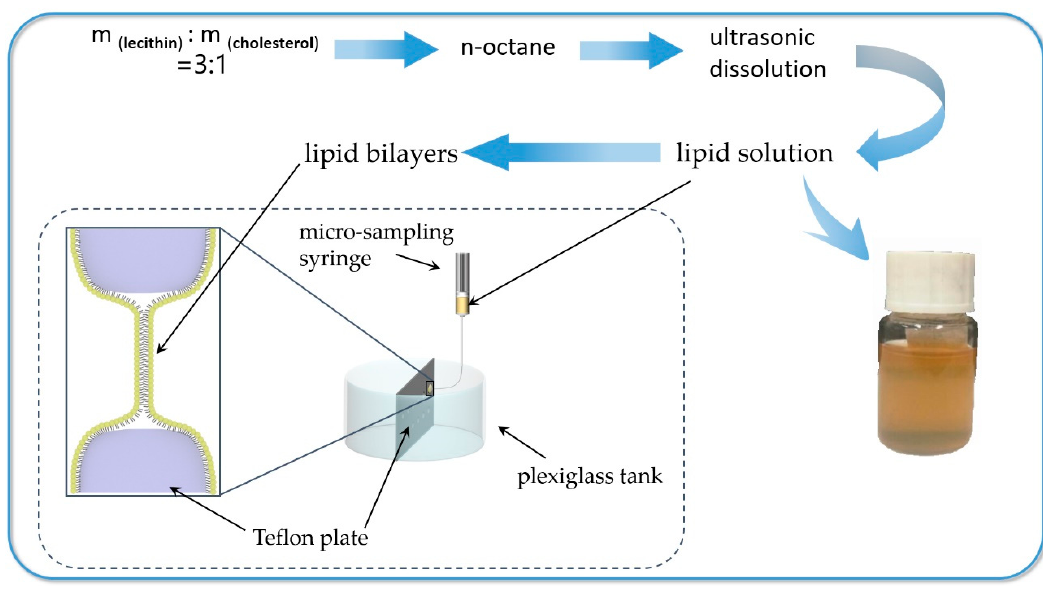
Figure 2. Flowchart for the Preparation of lipid bilayers.